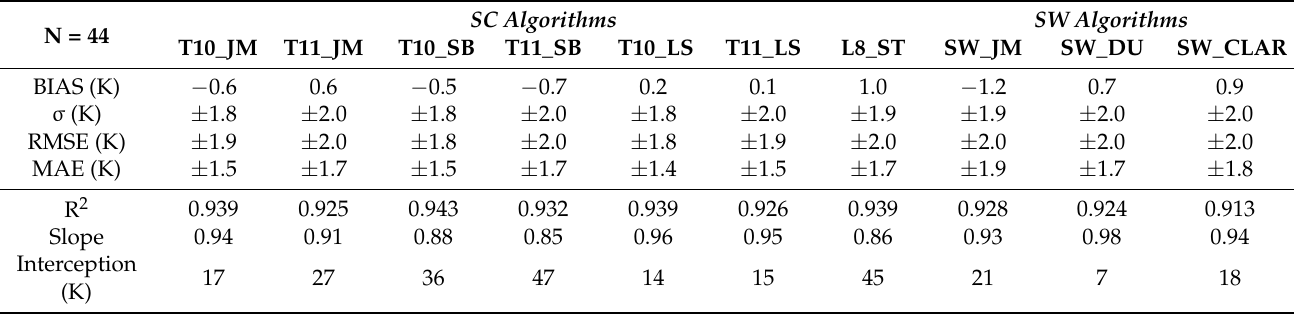
Figure 4. L8 images of LST for the study site obtained from the different SC and SW algorithms evaluated. Single-Channel algorithms were applied to both 10 (T10_) and 11(T11_) bands. Ti_JM refers to the Jimenez-Muñoz et al. [33] algorithm, Ti_SB refers to the SBAC tool, and Ti_LS refers to the linear approximation of the SBAC tool. L8_ST is the operational L8 LST product. SW refers to the Split-Window algorithms presented, these being SW_JM for Jimenez-Muñoz et al. [33], SW_DU for Du et al. [42], and SW_CLAR for the algorithm proposed in this work (Section 2.1.6). This is an example corresponding to the L8 image acquired on 2018/07/24. The same colormap applies for all images. Table 4. Statistics of the differences in terms of LST ( T-T g ) for the different algorithms. Single-Channel algorithms were applied to both 10 (T10_) and 11(T11_) bands. Ti_JM refers to the Jimenez-Muñoz et al. [32] algorithm, Ti_SB refers to the SBAC tool, and Ti_LS refers to the linear approximation of the SBAC tool. L8_ST is the operational L8 LST product. SW refers to the Split-Window algorithms presented, these being SW_JM for Jimenez-Muñoz et al. [33], SW_DU for Du et al. [42], and SW_CLAR for the algorithm proposed in this work (Section 2.1.6). N = 44